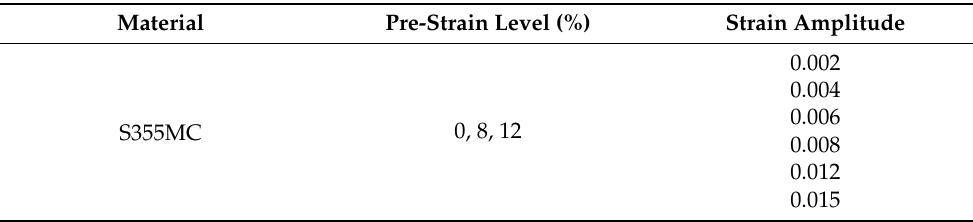
Table 2. LCF testing